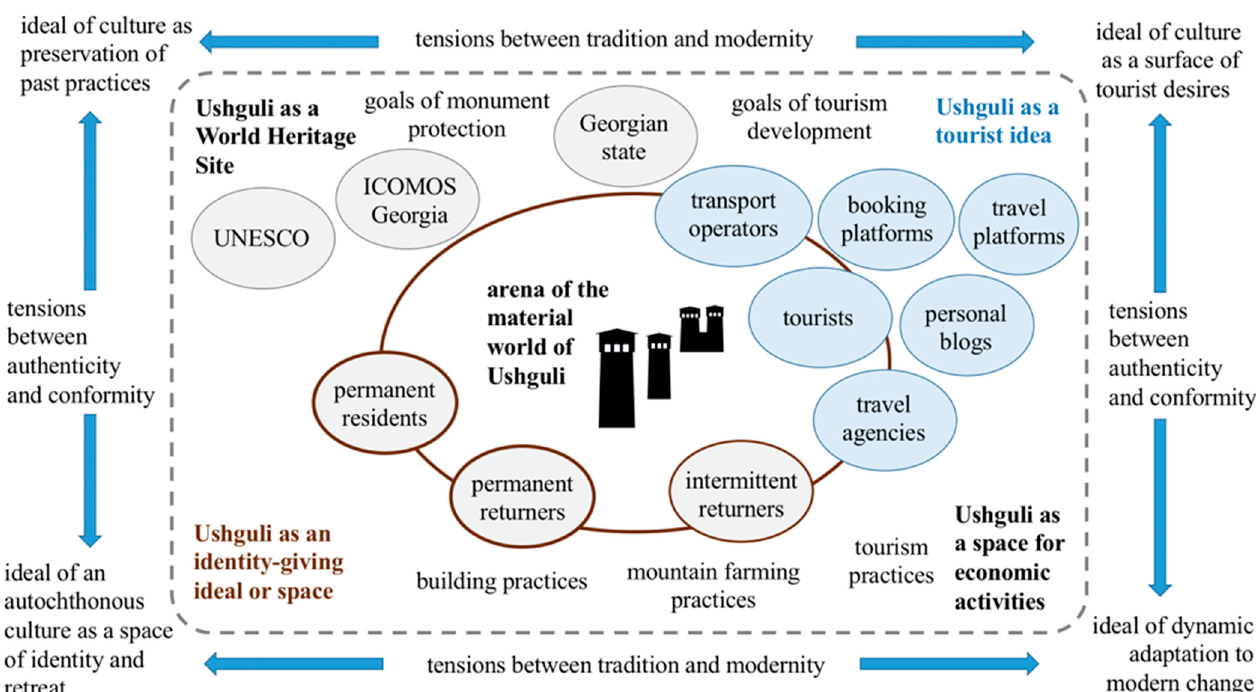
Figure 5. Social arena of impacts on the material space of the village community of Ushguli (Applis 2022).